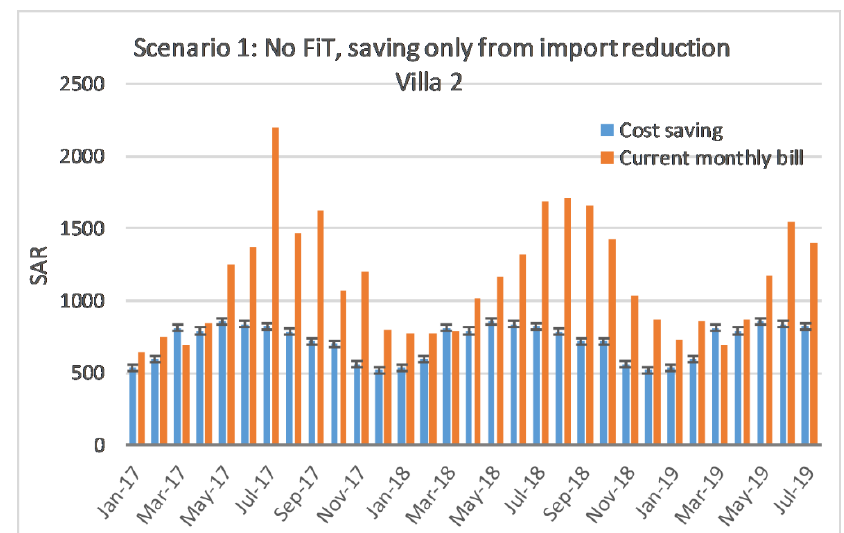
Figure 29. Cost saving from the PV panels generated power, for Villa 2, for 31 months (January 2017 – July 2019), only from import reduction (no FiT).